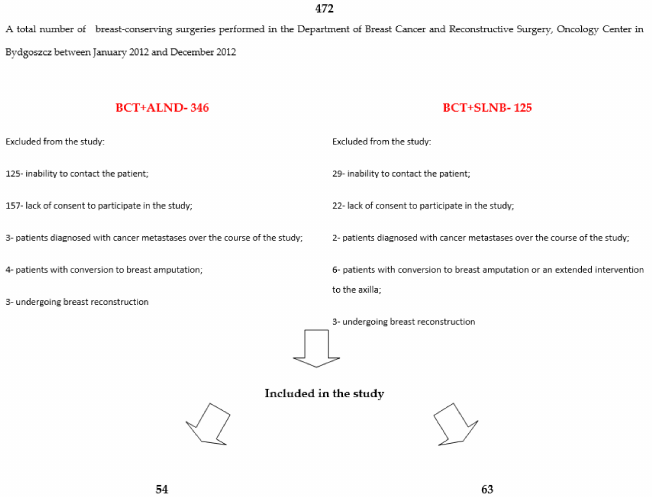
Figure 1. Study scheme describing patient exclusion from the study. BCT+SLNB: breast-conserving therapy+sentinel lymph node biopsy, BCT+ALND: breast-conserving therapy+axillary lymph node